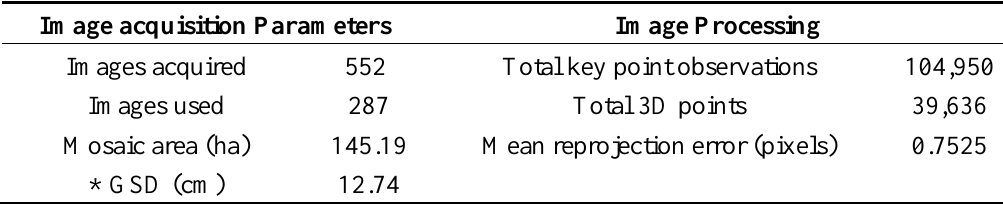
Table 2. Parameters used to generate the DAI-based canopy height